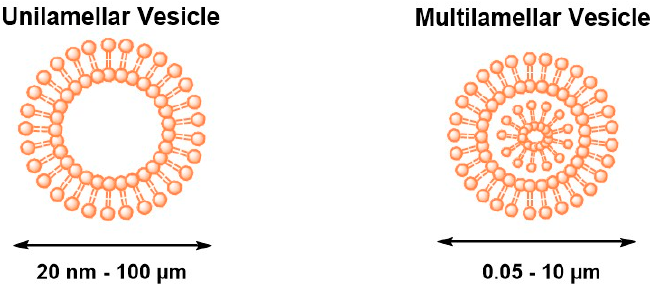
Figure 4. Schematic drawing of two different types of liposomes.